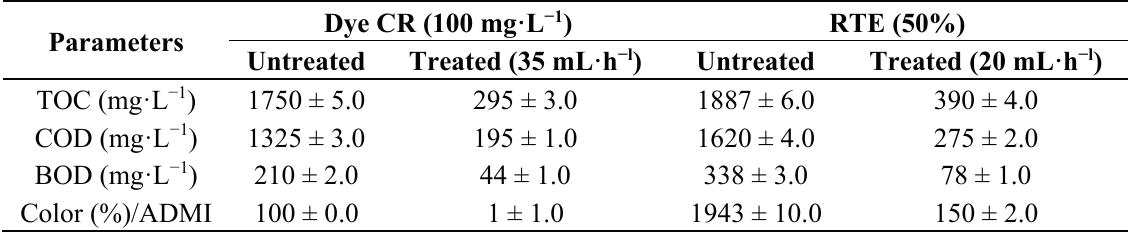
Figure 5. Decolorization of CR dye (100 mg·L − 1 ) and RTE (50%) by PUF-immobilized microbial consortium under upflow column bioreactor conditions at various flow rates. Data points indicate the mean of three independent replicates; ±SEM is indicated by error bars. Table 2. Characterization of CR dye and RTE before and after treatment with PUF-mmobilized microbial consortium under upflow column bioreactor